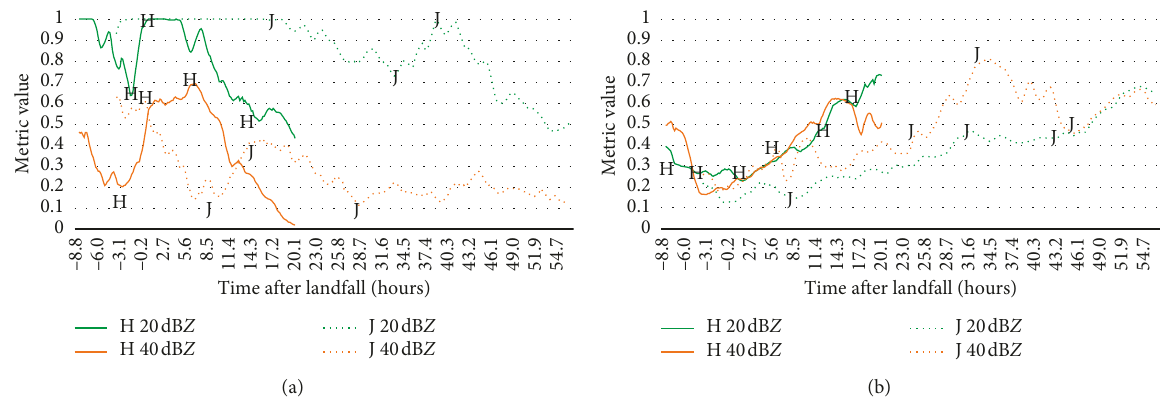
F IGURE 5: Values of (a) closure and (b) dispersion for all 20 and 40 dB Z polygons for Humberto (H) and Jeanne (J) aligned by time after landfall. Letters correspond to change points in Tables 4 and